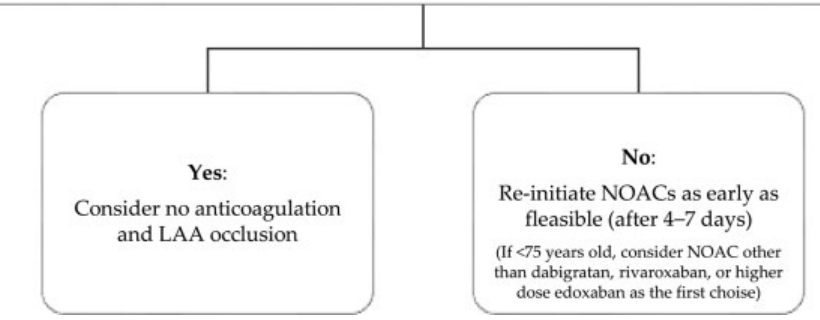
TH Open Vol. 5 No. 2/2021 © 2021. The